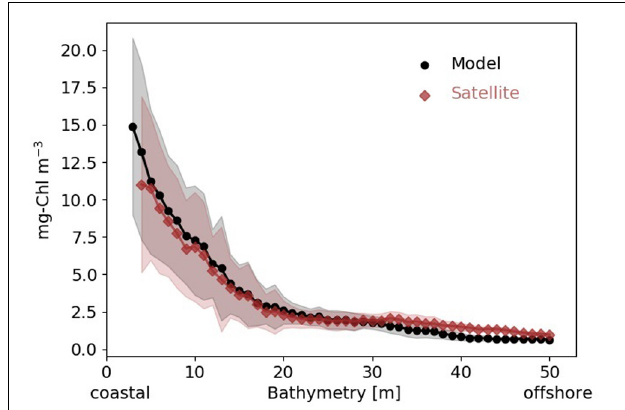
FIGURE 2 | Mean surface Chl concentration (black circles: model simulation, red diamonds: satellite data) 1997–2012 averaged along depth bands from coast to offshore in the SNS. Shading indicates standard deviation within depth band.